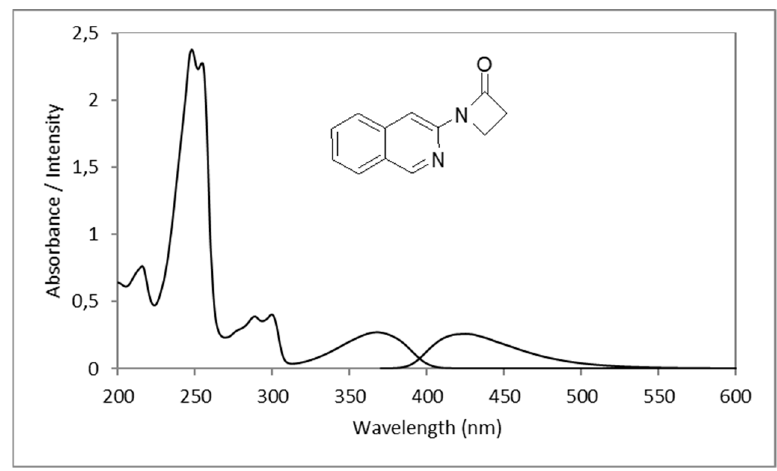
Figure 3 . Absorption and fluorescence spectra of 1-(isoquinolin-3-yl)azetidin-2-one ( 3a ).